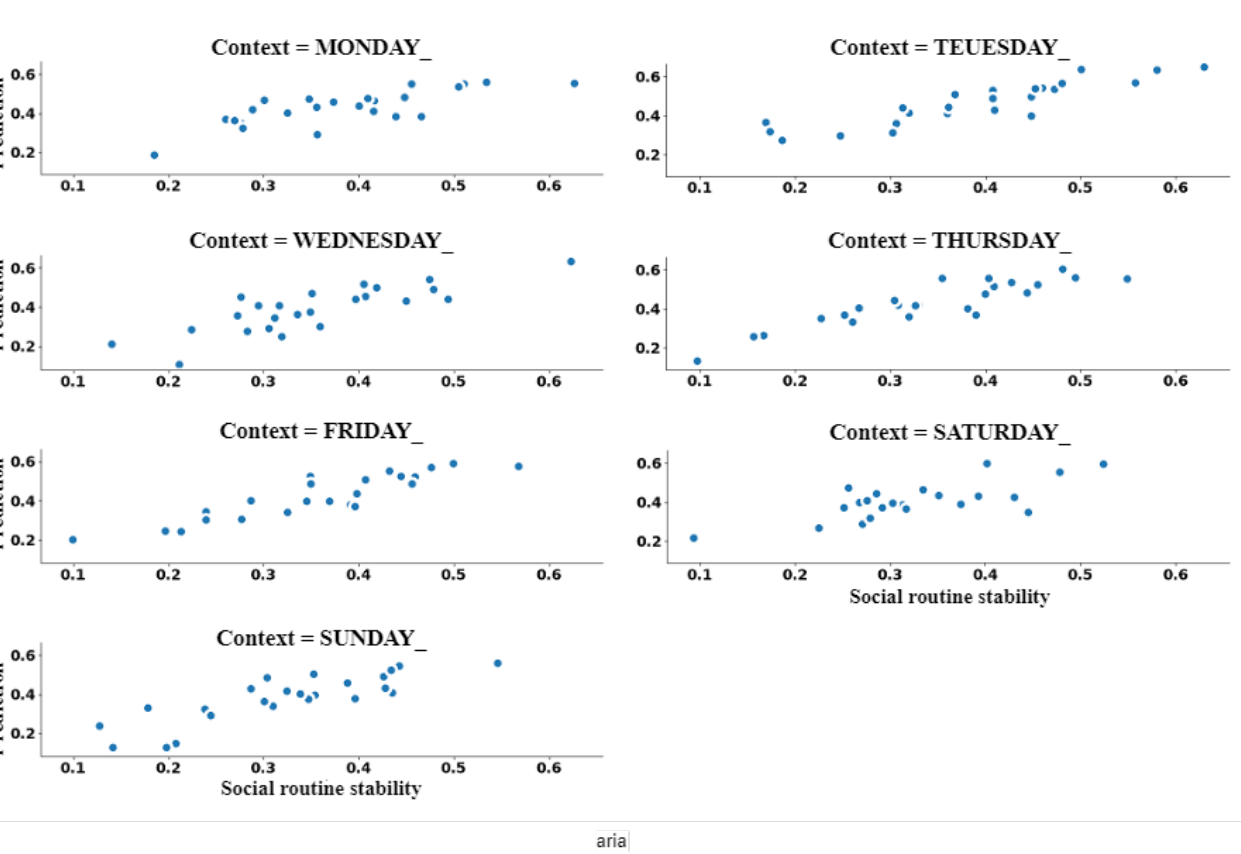
Figure 14. Correlation between prediction performance of sociability pattern and social routine for each Context Attribute (CA).